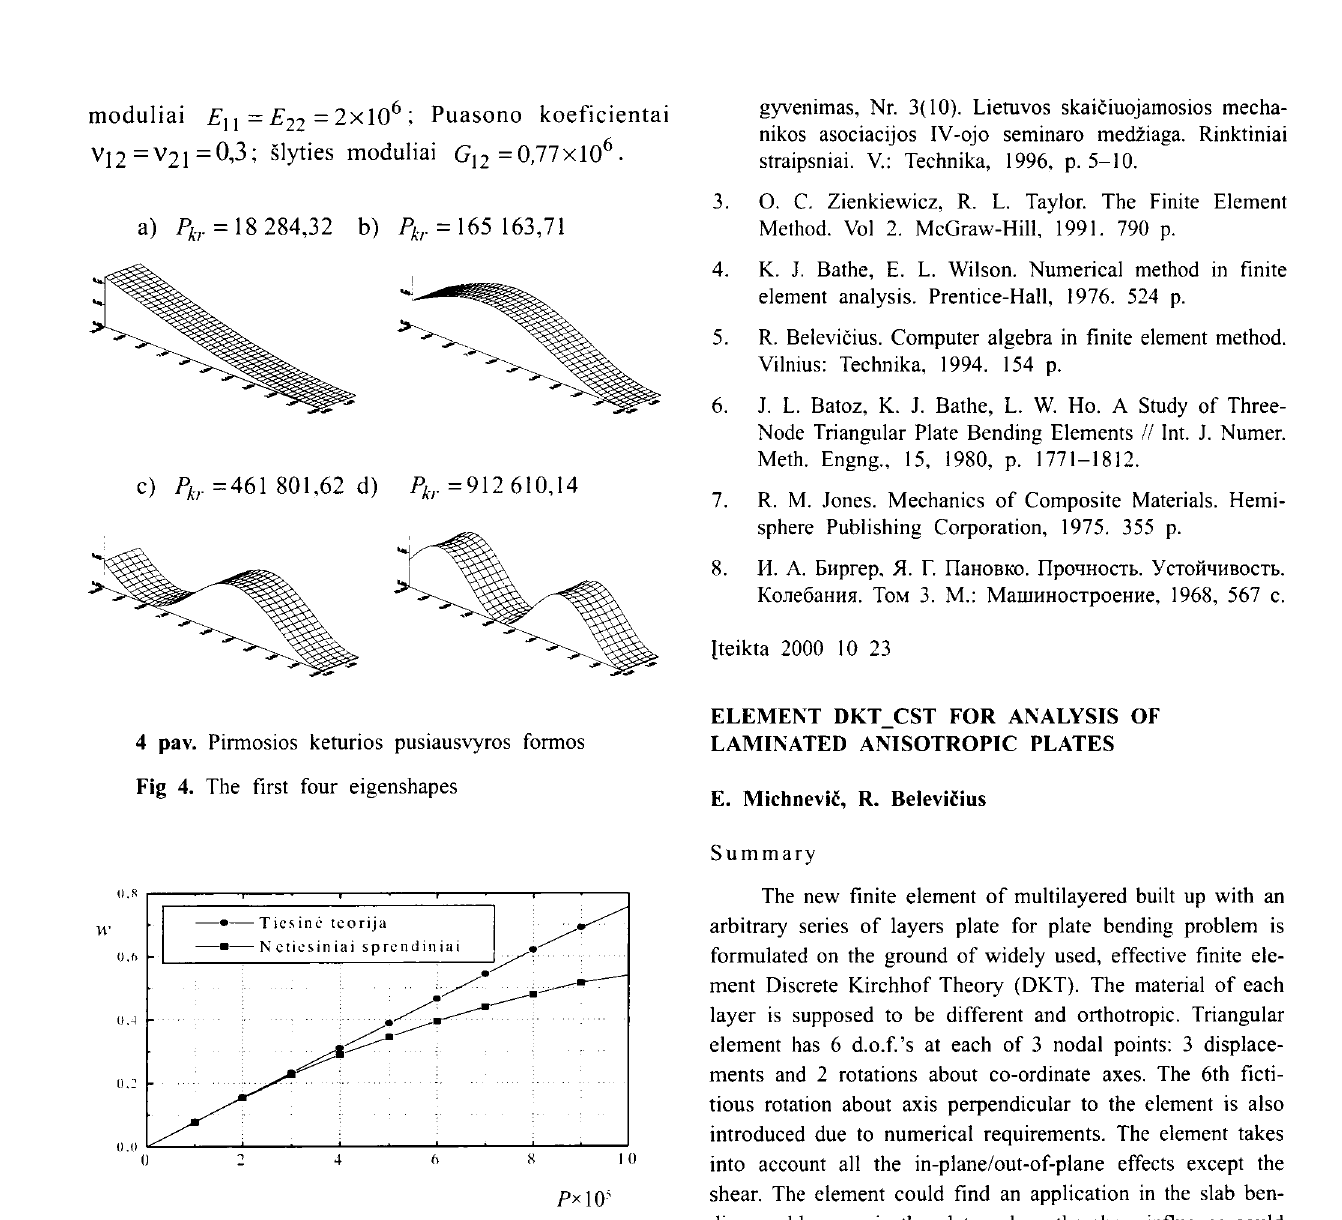
Fig 5. Deflection of central point Skaiciavimai rodo, kad 1enkiam4 ploksteli4 uzda viniams membranini4 deformacij4 efektas pasireiskia, kai poslinkiai virsija 0,25 ploksteles storio (5 pav.).